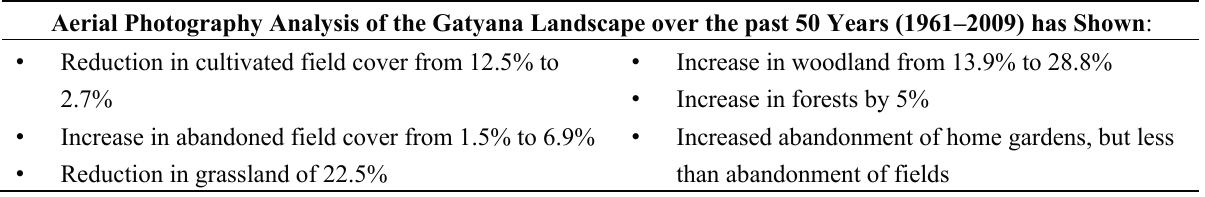
Table 1. Landscape change in Gatyana over a 50-year